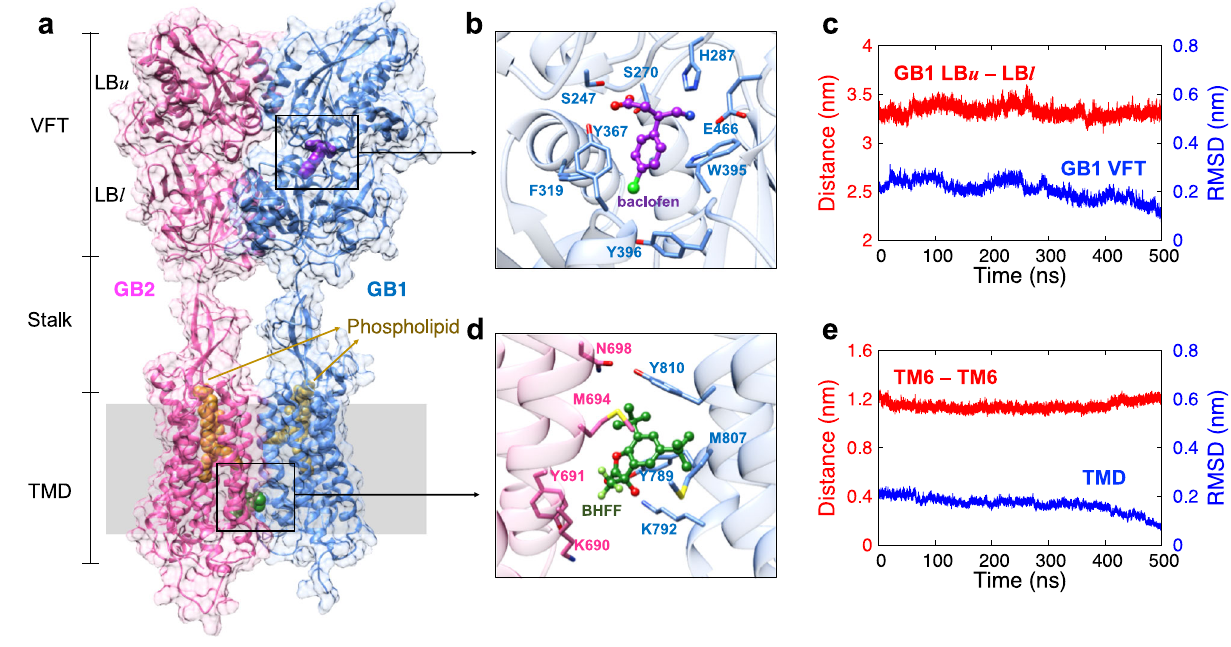
Fig. 1 | The activated structure of GABA B R heterodimer but without GP. a The GABA B R heterodimer structure contains the agonist (baclofen) attached to GB1- VFT,withthePAM(BHFF)attheGB1-GB2TMDinterface,andphospholipids(POPE) within each TMD core. b The agonist in the binding site anchors LB u and LB l , keeping the closed conformation of GB1-VFT. c We monitored with time the dis- tance between GB1-LB u (the centre of mass of C α for residues 222 – 235 and